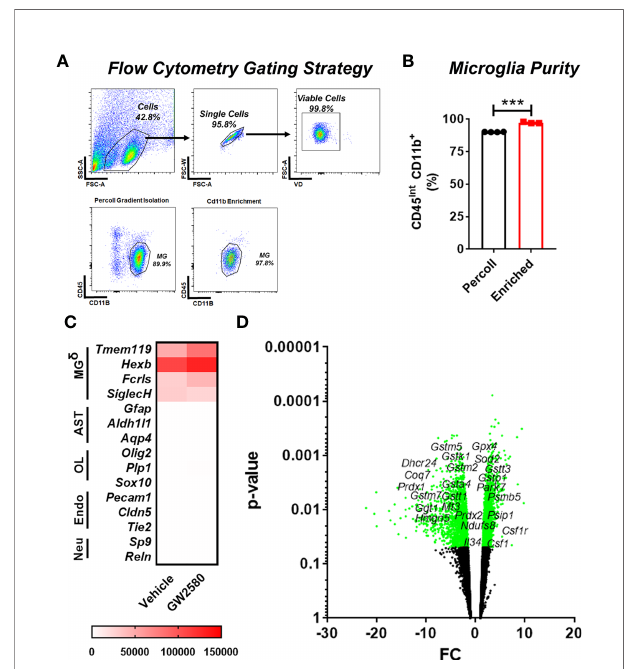
FIGURE 4 | Microglia transcriptional changes induced by GW2580 treatment. (A – D) Mice were gavaged with vehicle or GW2580 for 8 days then brains were collected, and microglia were isolated by Percoll gradient centrifugation, enriched by positive selection by magnetic associated cellular sorting (MACS) using antibodies speci fi c for CD11b and changes to the transcriptome assessed by RNA-seq. (A, B) Microglia purity was determined before (Percoll) and after (enriched) MACS enrichment by fl ow cytometry. Representative fl ow cytometry gates (A) and cell purity following Percoll gradient centrifugation and positive selection (B) . (B) n=3-4 mice per condition. (C) Mean expression values of select microglia, astrocyte, oligodendrocyte, endothelial and neuron speci fi c cell lineage genes following transcriptomic analysis of microglia isolated from vehicle ( left ) and treated ( right ) mice (n=5 per condition). Scale bar is gene expression level (RMPK). d = Genes for microglia were enriched. (D) Volcano plot representing all the genes detected with the RNA sequencing experiment, signi fi cant genes are represented in green, including Csf1, Csf1r and Tspo , as well as the ROS related genes. Data are expressed as means ± standard error (S.E.). Statistical signi fi cance is represented by p-value < 0.001